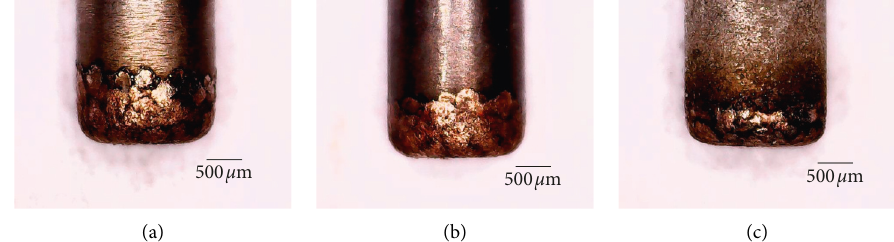
Figure 9: Shape changes of copper-tungsten alloy composite tools. (a) Common tool. (b) Nickel-coated composite tool. (c) Diamond- nickel-coated composite